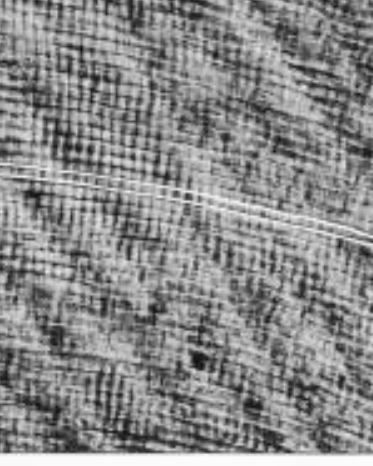
Figure 4 High-magnification detail from the thin section (Fig. 3), showing the regu­ lar growth structures found in enamel (polarized transmitted-light microscopy). The approximately weekly growth layers, known as brown striae af Retzius, can be seen running from bottom right to top left. The enamel prisms (one outlined by two white lines) run across from right to left, and along their length the cross-striations are visible approximately 4 microns apart. The cross-striations represent circadian growth markers and they can be used to determine the precise timing of crown for­ mation, as well as the number of days between any disruption of this formation. (Circadian rhythms occur with a period­ icity very close to the 24-hour Figure 3 Detail of a thin section, c. 700 microns long, of the tooth shown in Figure 2 (polarized transmitted-light micros­ copy). The surface, enamel and dentine are labelled S, E and D. The dark vertical lines (L}, seen radiating away from the enamel/dentine junction (EDJ}, represent periods during which tooth formation was disrupted and are associated with the sur­ fa ce hypoplastic defects visible in Figure 2.